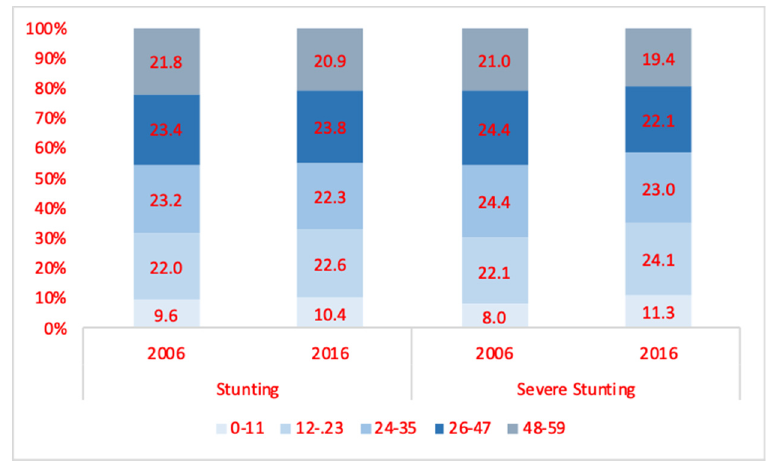
Figure A2. Distribution (%) of stunted and severely stunted children (below five years) by age-groups in India, NFHS, 2006, and 2016.